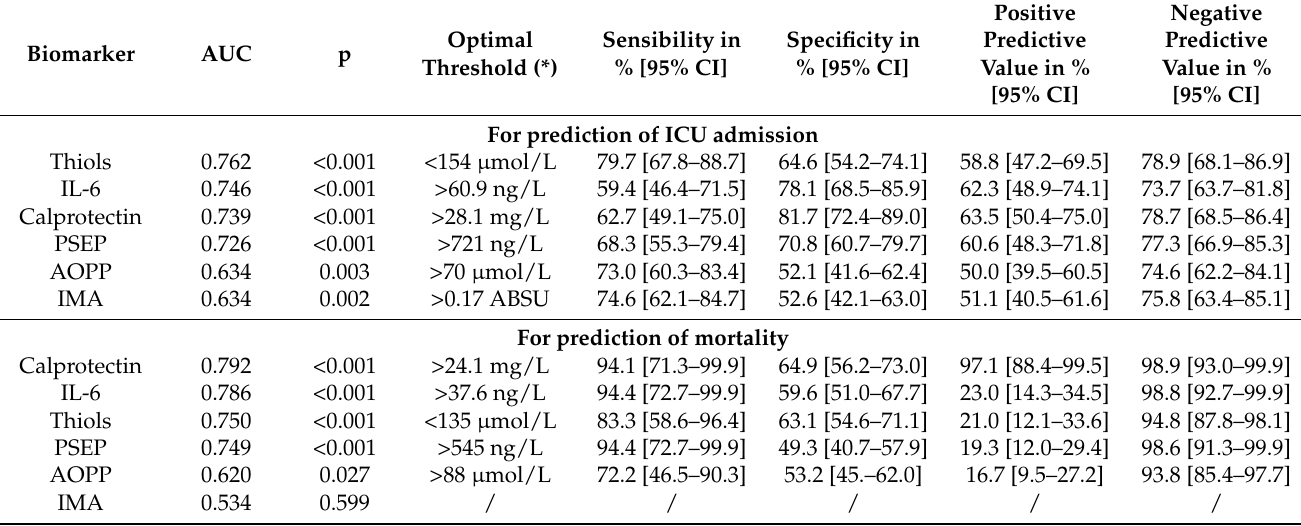
Table 2. AUC, optimal threshold, sensibility and specificity obtained by the ROC curves for prediction of ICU admission and